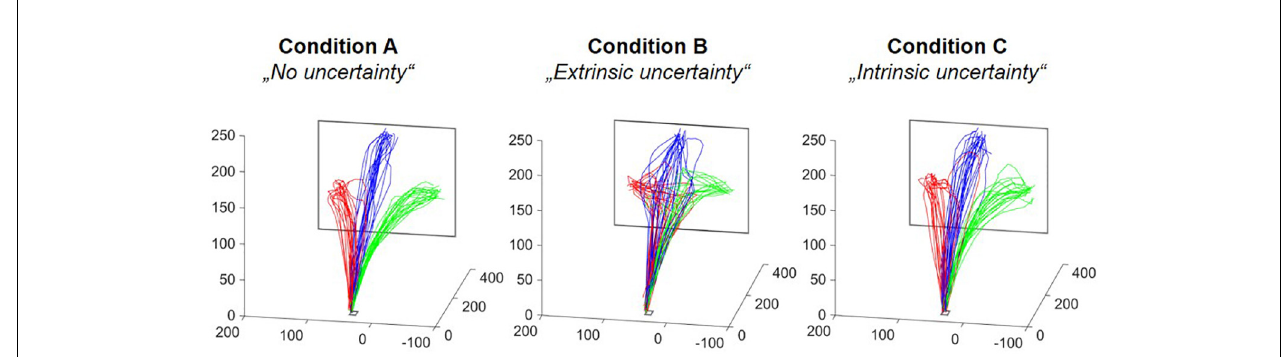
FIGURE 4 | Reach trajectories of one representative participant. Each subfigure depicts all reach trajectories executed in one of the three experimental conditions. The different colors relate to the different final reach targets. The axes represent the three dimension in space plotted in mm. The differences in between-trial variability of fingertip trajectories become clearly visible.